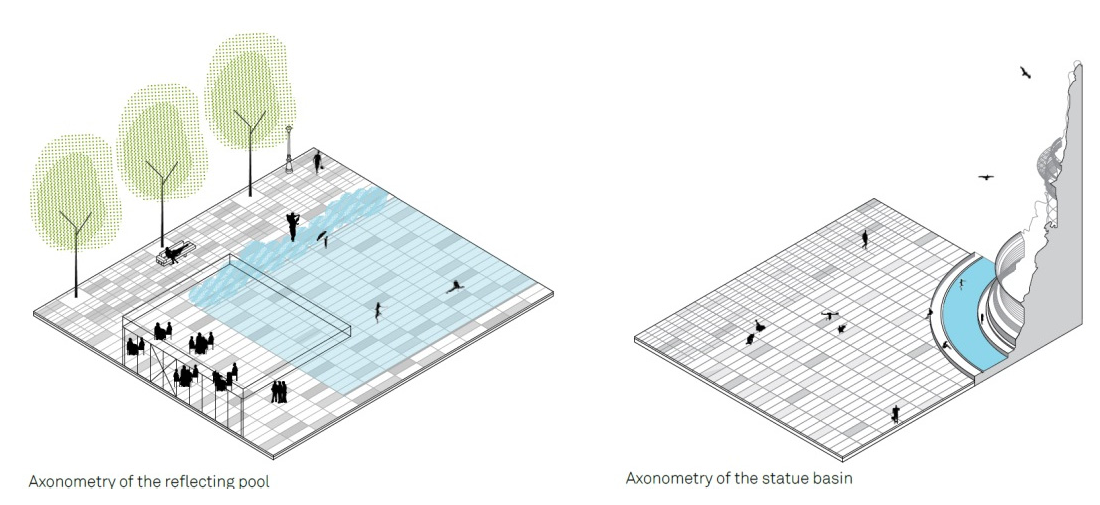
Figure 3. Axonometric of the ( a ) Reflecting pool; ( b ) Statue basin. Adapted with permission from Trévelo & Viger-Kohler